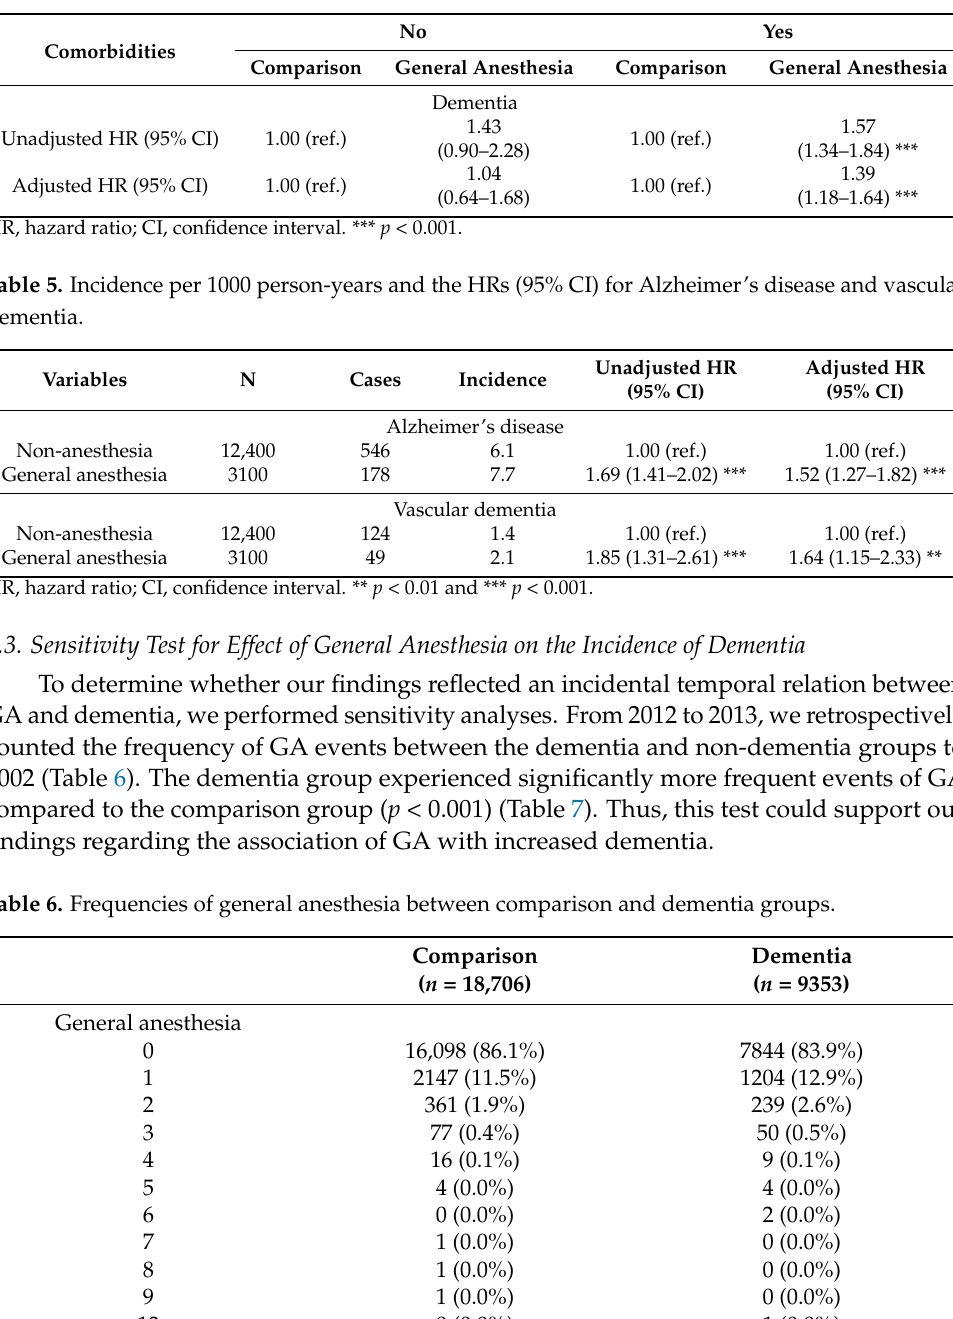
Table 4. Hazard ratios of dementia by the comorbidity status of the patients.